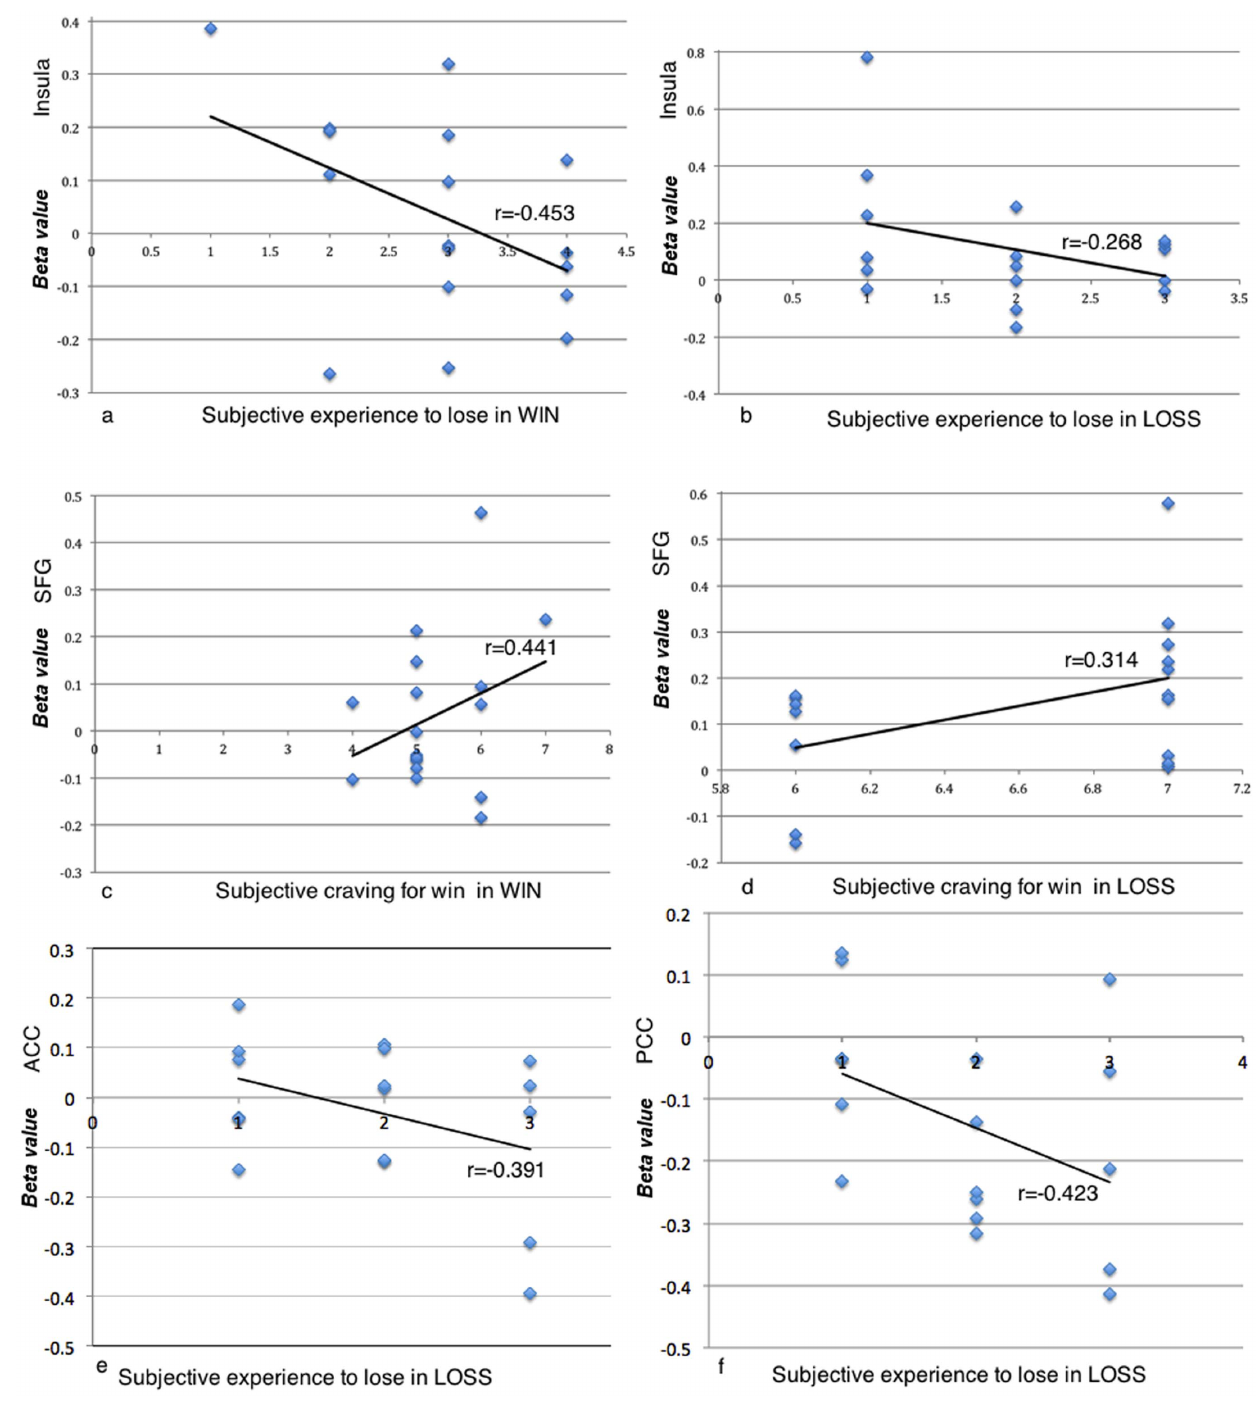
Figure 3. Correlations between brain activations and self report experience. a ) Correlation between brain activations in insula and the participants’ experiences to lose in WIN condition. b ) Correlation between brain activations in insula and the participants’ experiences to lose in LOSS condition. c ) Correlation between brain activations in SFG and the participants’ craving for win in WIN condition. d ) Correlation between brain activations in SFG and the participants’ craving for win in LOSS condition. e ) Correlation between brain activations in ACC and the participants’ experiences to lose in LOSS condition. f ) Correlation between brain activations in PCC and the participants’ experiences to lose in LOSS condition.